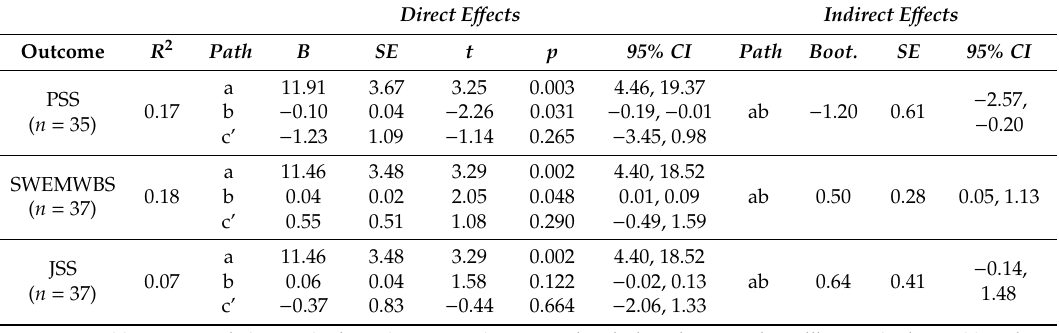
Table 4. Mediation analyses of mindfulness on perceived stress, mental wellbeing and job